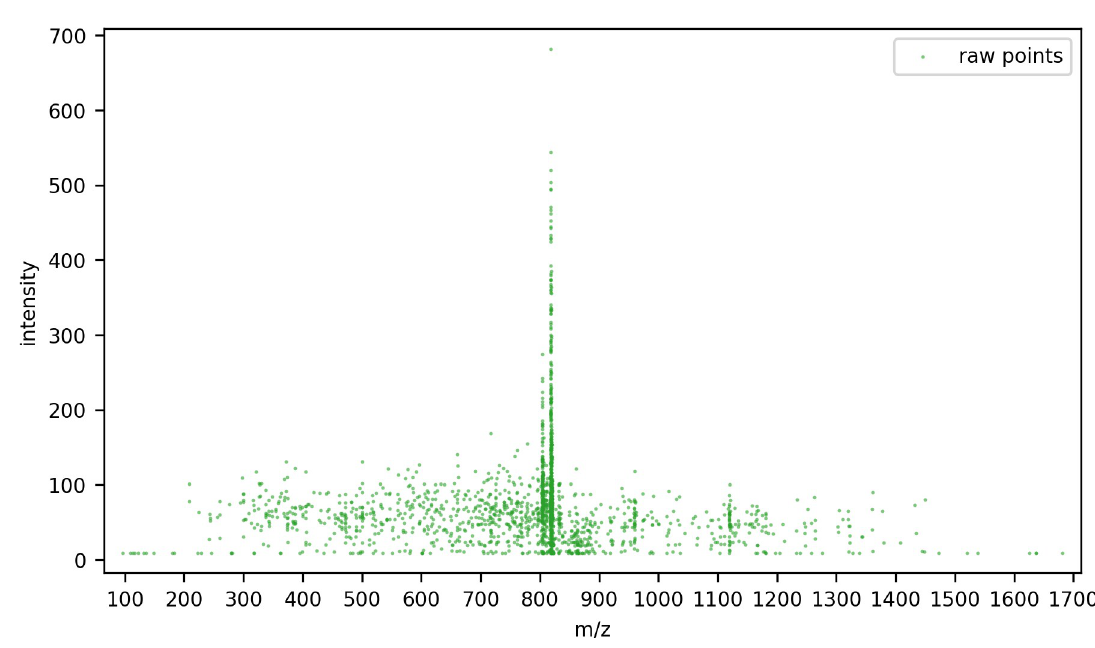
Fig 13. The raw MS2 points associated with an example precursor